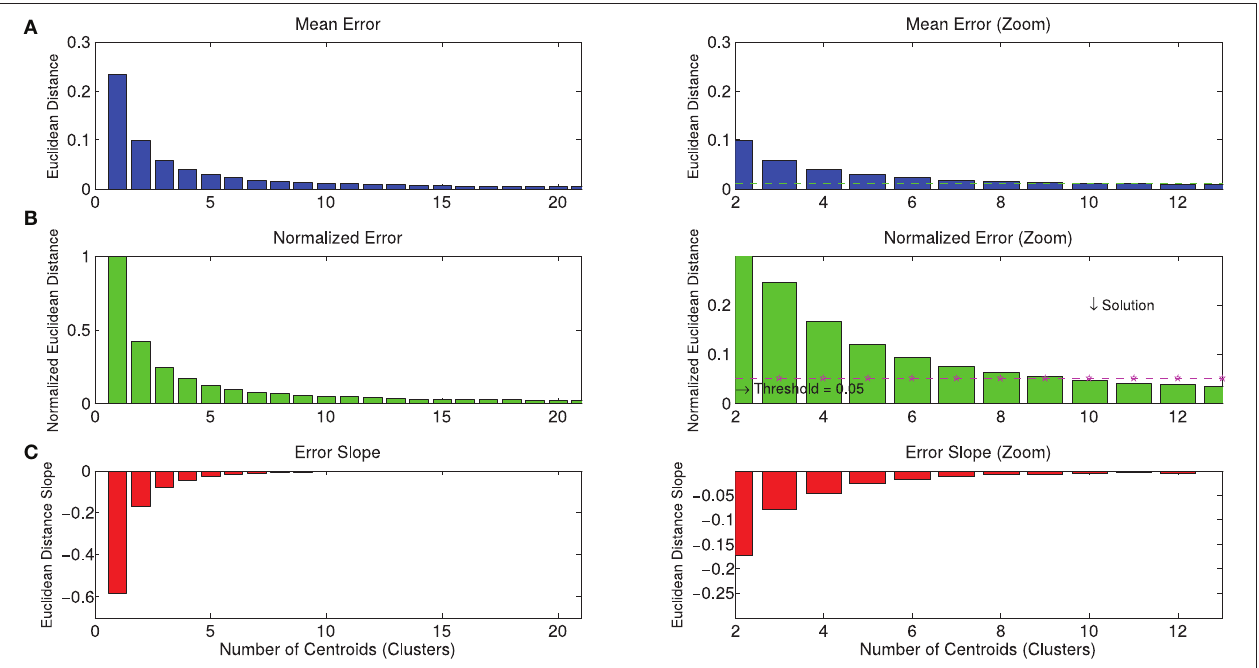
FIGURE 5 | Metrics for the selection of the correct number of clusters for the description of the dataset. Panel (A) describes the mean Euclidean distance between the centroids identified with the k-means algorithm and the synergies that belong to that centroids. Increasing the number of clusters, the mean Euclidean error decreases. Panel (B) reports the normalized error, considering the solution of order 1 as the maximum approximation error (when the dataset of spatial synergies is approximated with its mean—SSm). Increasing the order of the clustering, the mean error is progressively reduced. Panel (C) shows the derivative of the error (slope), indicating the entity of the reduction of the error in relation to the increase of the number of clusters. Right panels show a zoomed view of left panels. They show that, by imposing a threshold of a maximum tolerable mean error, the solution corresponding to a lower number of clusters can be selected. In the present study, the maximum normalized Euclidean error was reasonably set at 0.05*SSm, corresponding to a 10-cluster